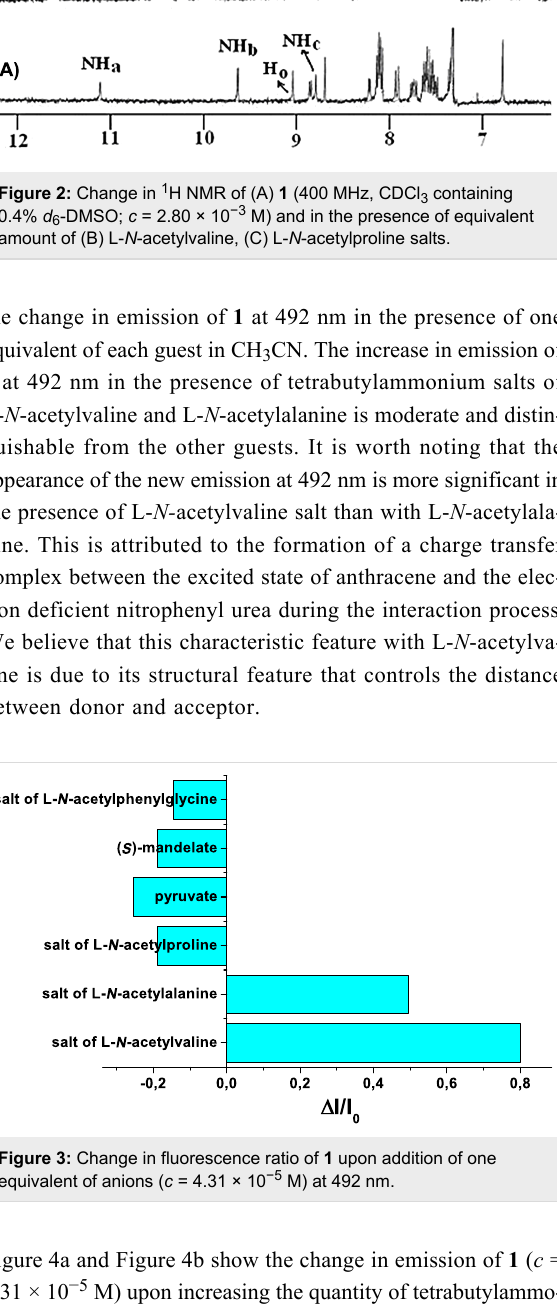
Figure 4a and Figure 4b show the change in emission of 1 ( c